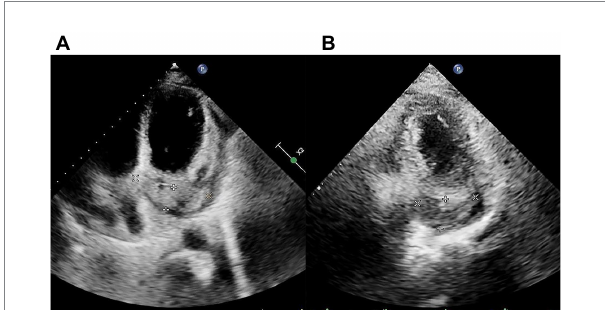
FIGURE 2 Transthoracic echocardiography (TTE) findings pre- and post- chemotherapy. (A) Pre-chemotherapy TTE revealing filling of the coronary sinus with inhomogeneous echogenic material measuring approximately 21.4 mm × 68.3 mm. (B) TTE after the second cycle of chemotherapy showing filling of the coronary sinus with inhomogeneous echogenic material measuring approximately 22.5 mm × 43.4 mm are shown.